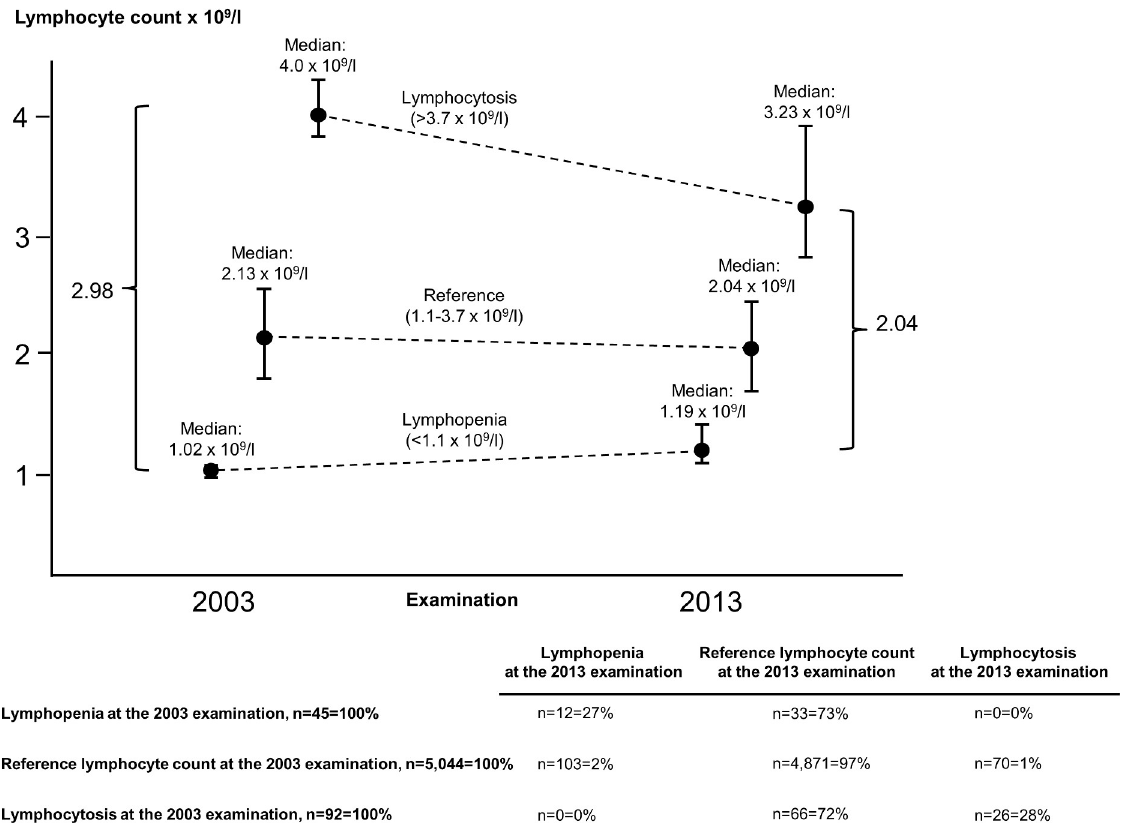
Fig 2. Regression toward the mean of lymphocyte counts, categorized as lymphopenia ( < 1.1 × 10 9 /l), reference lymphocyte count (1.1– 3.7 × 10 9 /l), and lymphocytosis ( > 3.7 × 10 9 /l) at the date of examination in 2003 in the Copenhagen General Population Study. When categorizing lymphocyte counts, lymphopenia was defined as a lymphocyte count below the 2.5th percentile, the reference category was defined as a lymphocyte count between the 2.5th and 97.5th percentile, and lymphocytosis was defined as a lymphocyte count above the 97.5th percentile. Median values and interquartile ranges of 5,181 individuals at the 2003 examination (left) and the same individuals— maintaining the 2003 categorization—at the 2013 examination (right). Regression dilution ratio is 2.04/2.98 = 0.68. The table below the graph gives the percentage of individuals in each lymphocyte category at the 2003 examination (rows) and at the 2013 examination